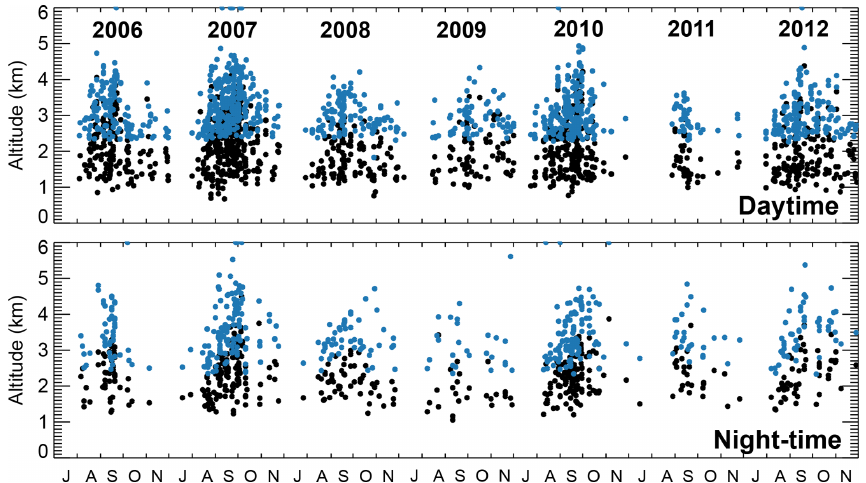
Figure 9. Time series of the CALIOP smoke plumes (2006–2012) for daytime and nighttime observations. Each dot represents the maximum (blue) and median (black) smoke plume height above the terrain. Eighteen points for which the CALIOP height exceeds 6km are plotted at the top of the